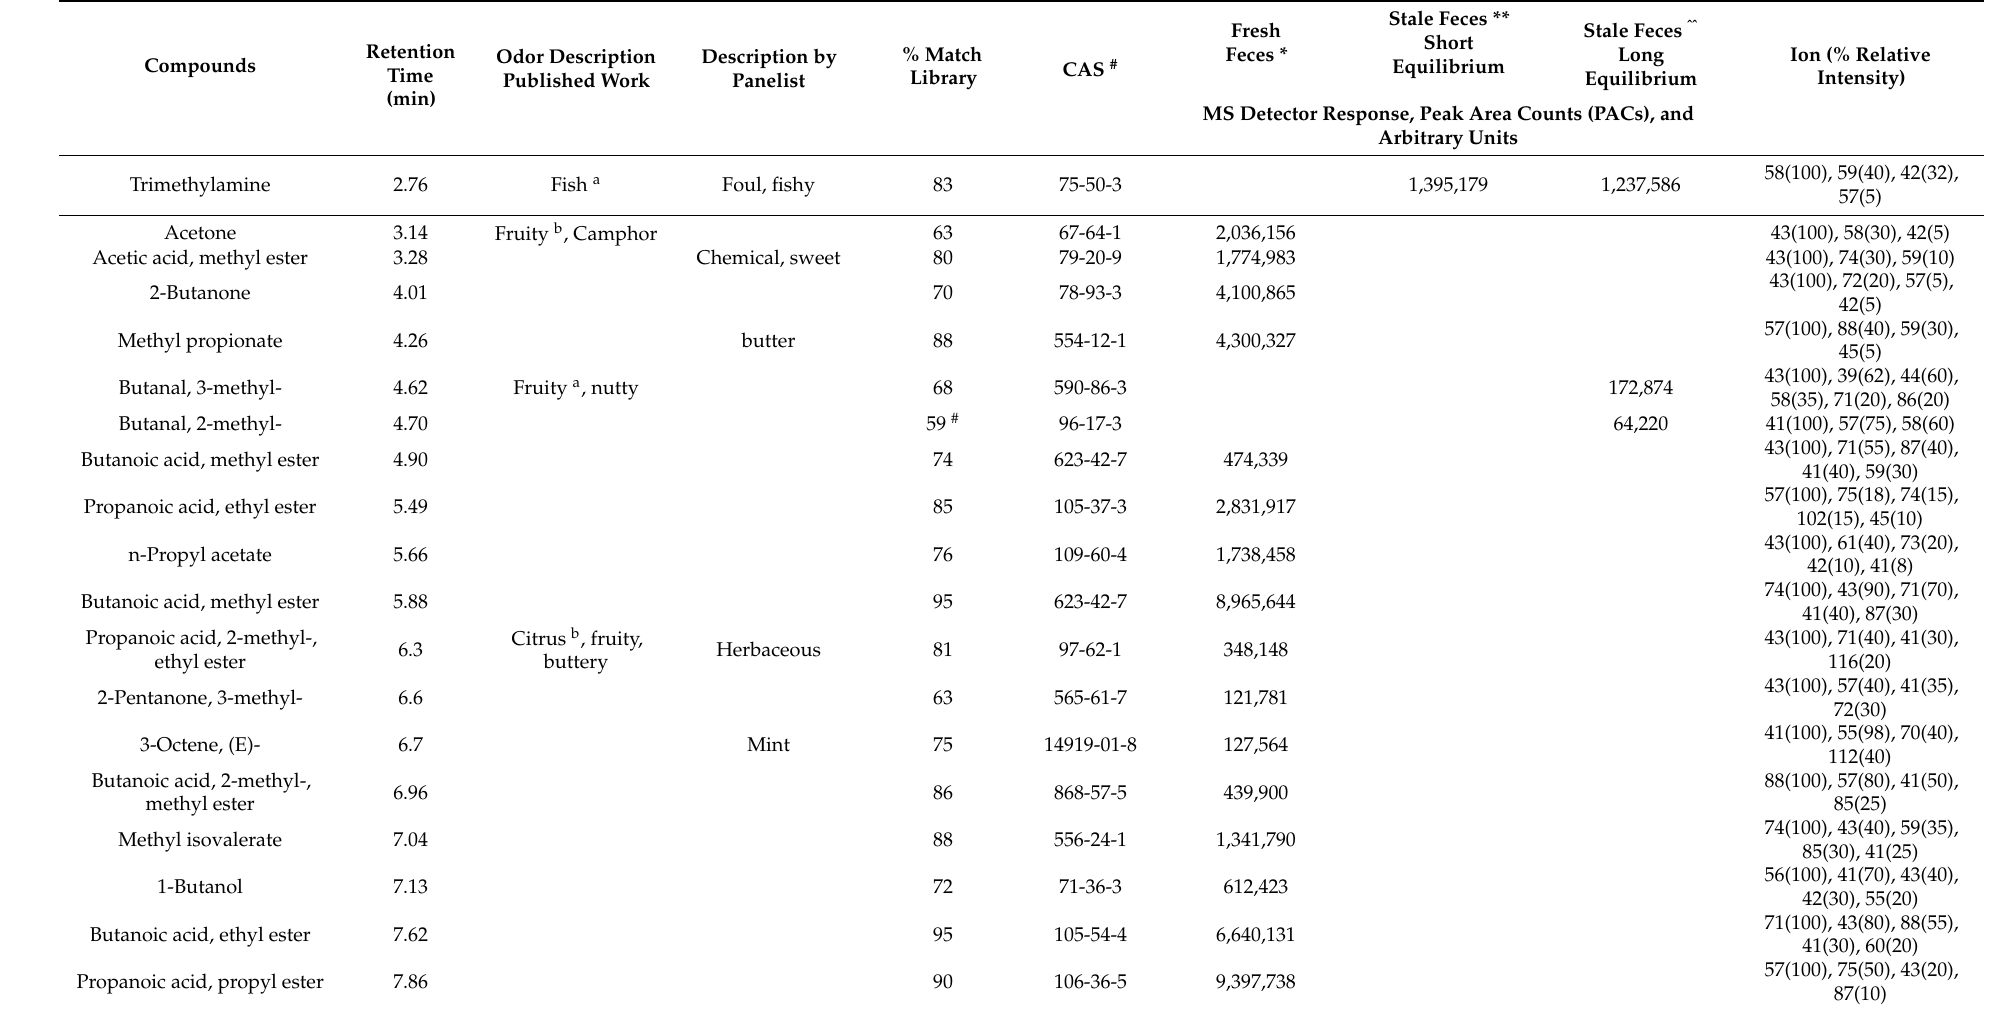
Table 3. Compounds identified in the headspace of fresh and stale cat